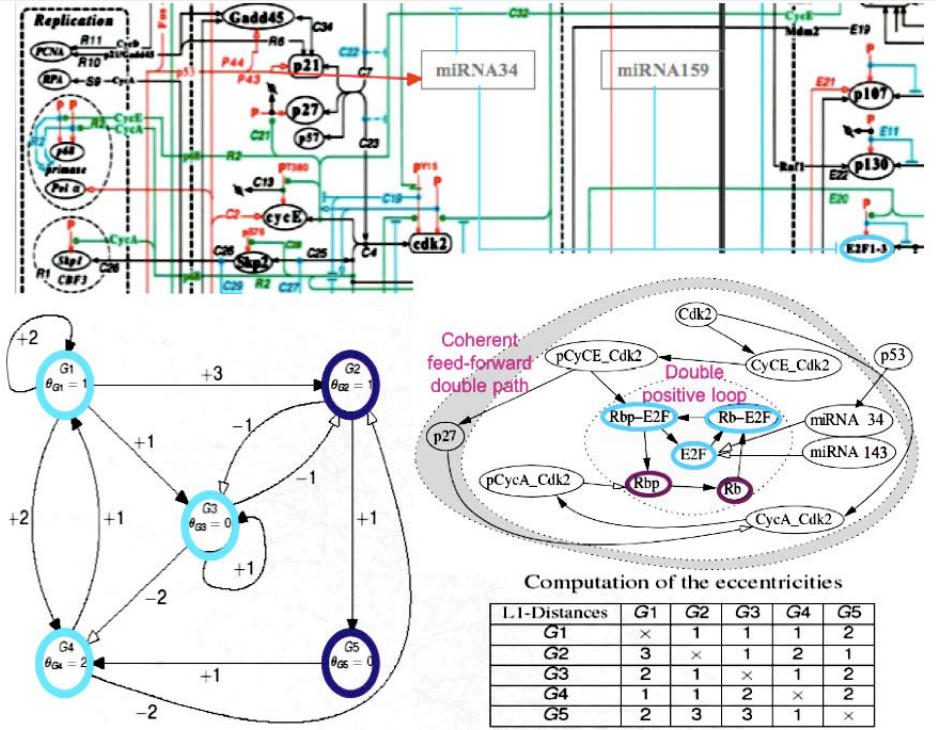
Figure 3. Schematic view of the cell cycle regulatory network (top, after [28]); zoom on the subnetwork centred on E2F (middle right); complexification of the subnetwork (middle left); computation of its eccentricities (bottom right). These representations highlight how miRs control globally the cell cycle by the manner they are connected to its regulatory network. Note the high eccentricity of miRNAs, revealing their upstream location in the regulatory